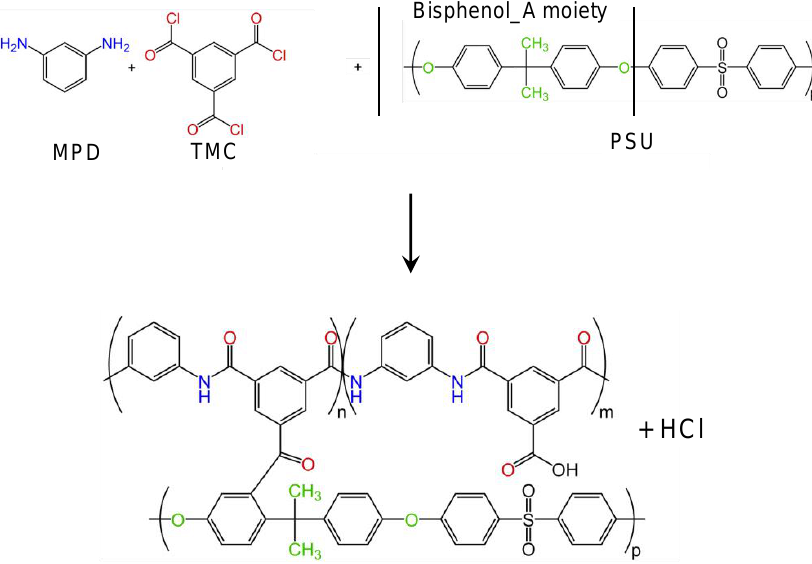
Figure 3. Reaction scheme of the formation of the thin polyamide (MPD + TMC) layer covalently attached to the porous electrospun PSU support.